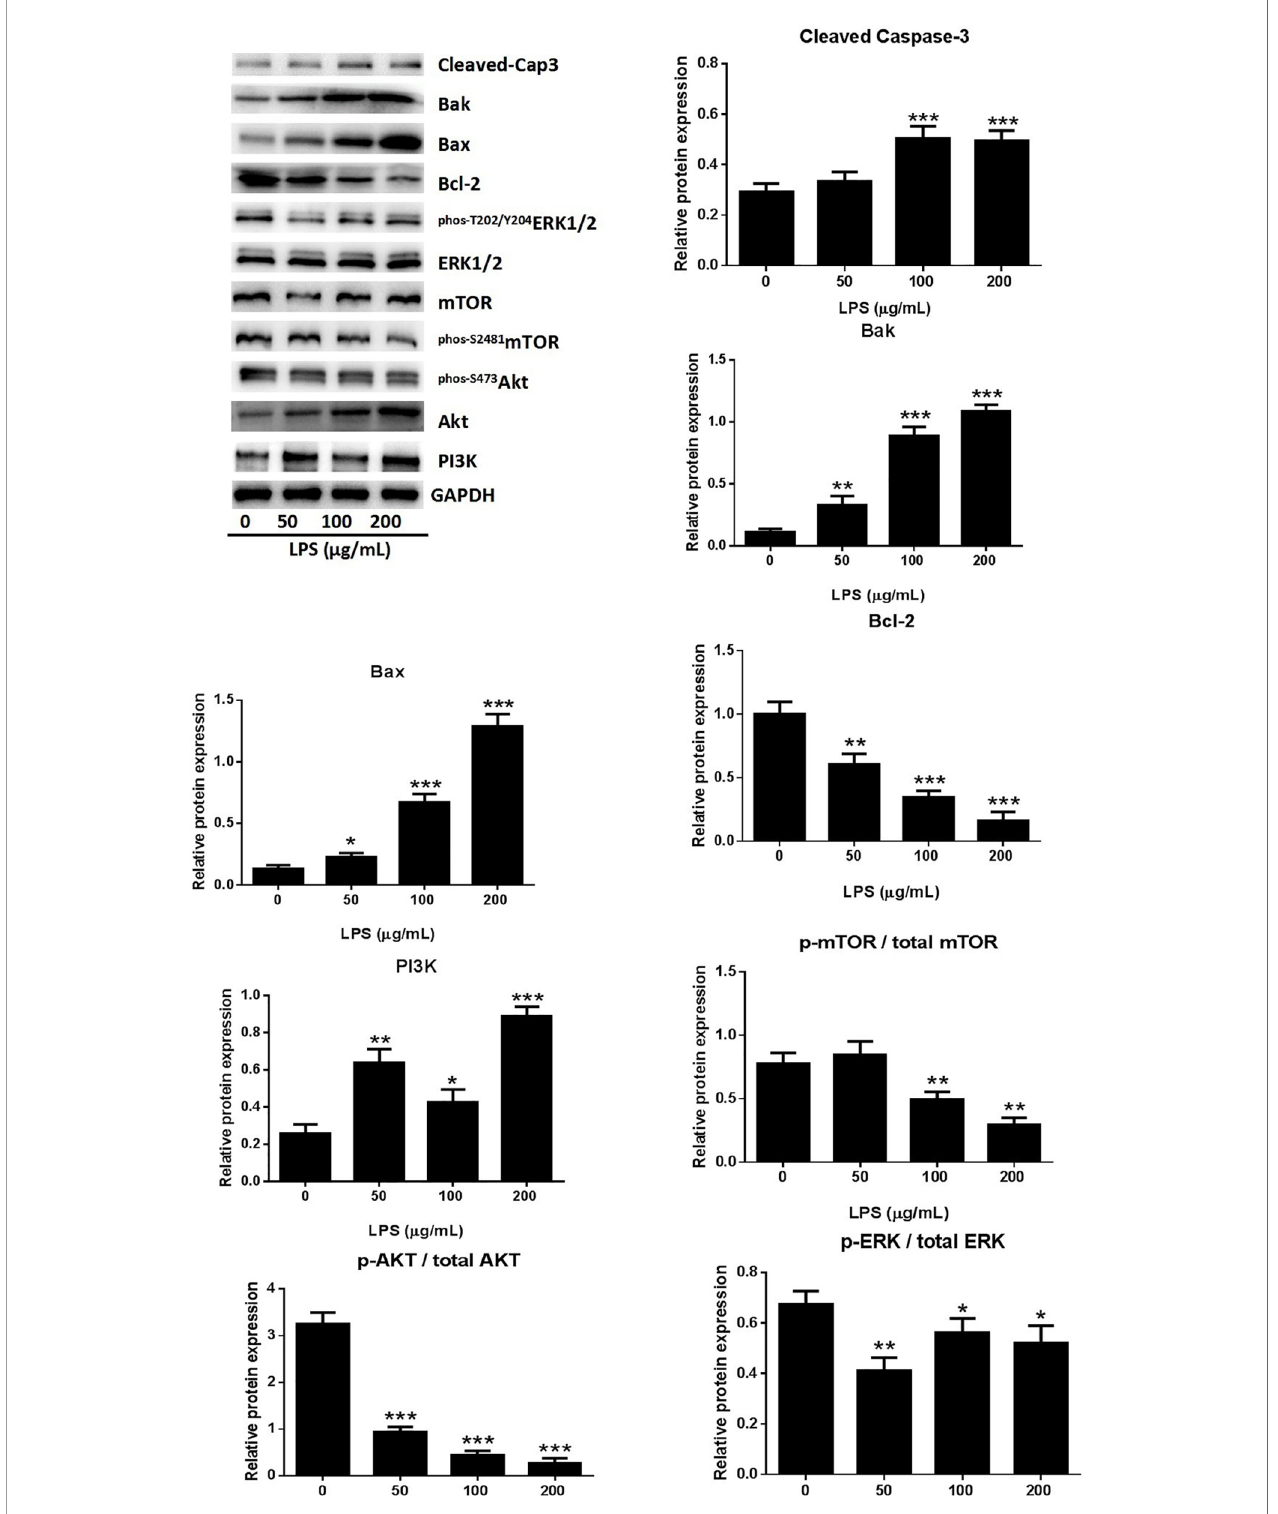
FIGURE 2 | LPS induced A549 cell apoptosis through the PI3K/AKT/mTOR/ERK1/2 pathway. Western blot analysis and quanti fi cation of apoptosis-related proteins and PI3K/AKT/mTOR/ERK1/2 signaling-related proteins in A549 cells stimulated with various concentrations of LPS for 24 h. *p < 0.05, **p < 0.01, and ***p < 0.001 compared with the control group. Graphs show the mean ± SD of triplicate wells and represent three independent